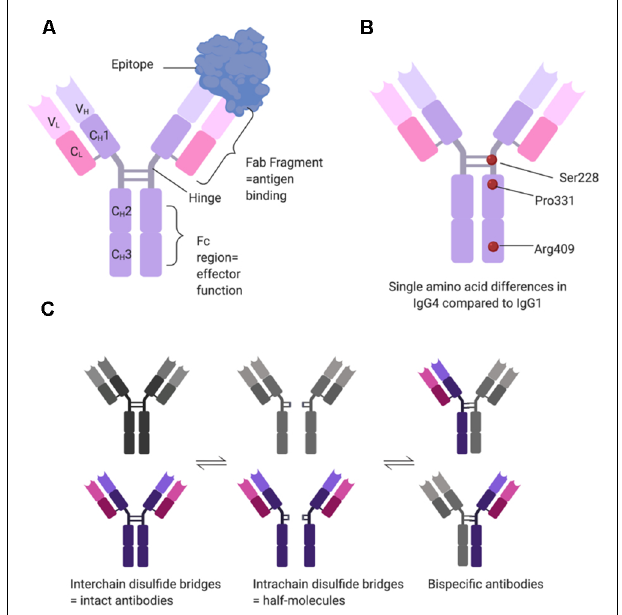
FIGURE 2 | Structural determinants of IgG4 subclass antibodies. (A) IgG4 consists of two heavy (H) and two light (L) chains, each with one variable (V) domain, and one (CL) or three (CH1–CH3) constant domains. In the hinge region, the two heavy chains are connected covalently by two interchain disulfide bridges. The variable domains and the first constant domain form the Fab fragment, which binds the antigen, while the hinge and the CH2–CH3 domains form the Fc region which provides effector function such as binding of C1q or Fc gamma receptors. (B) IgG1 and IgG4 have over 90% sequence homology, but single amino acid differences affect the structure and function of the antibody. Three relevant examples are serine at position 228 instead of a proline, allowing for structural flexibility and a switch to intrachain disulfide bridges. Proline at position 331 prevents binding of C1q, and arginine at position 409 leads to reduced non-covalent interactions between the two heavy chains. (C) Under reducing conditions (e.g., 1 mM glutathione), IgG4 can undergo Fab-arm exchange. The interchain disulfide bridges change to intrachain disulfide bridges, disconnecting the two half-molecules of the antibody. These then stochastically recombine with other half-molecules, forming bi-specific antibodies. Under reducing conditions, the different states of IgG4 are in equilibrium.